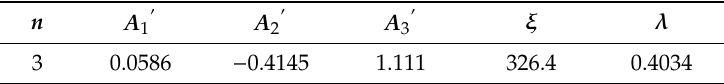
Table 2. Fitting parameters of shape function.